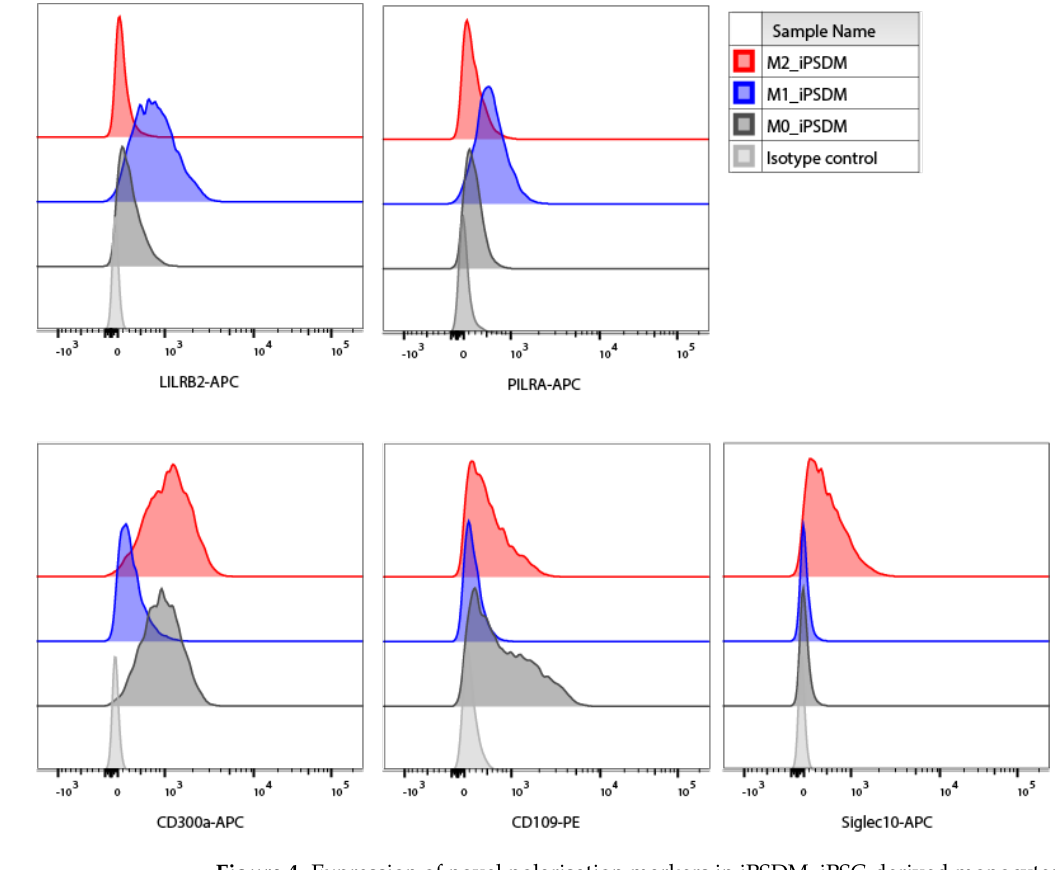
Figure 4. Expression of novel polarisation markers in iPSDM. iPSC-derived monocytes were differentiated to M Φ for 7 days and polarised with IFN γ + LPS or IL-4 for 48 h. Polarised iPSDM were Fc blocked, stained for LILRB2, PILRA, CD300a, CD109, and Siglec-10 and analysed by FACS Canto. Representative of four independent experiments.